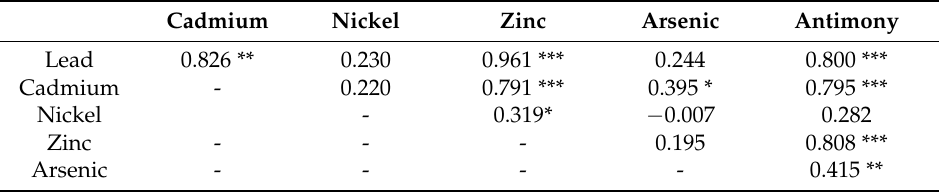
Table 6. The Pearson correlation coefficients matrix for chemical element concentrations (after logarithmic transformations) in soils of 38 households and surroundings from Santo Amaro City, 2008. Cadmium Nickel Zinc